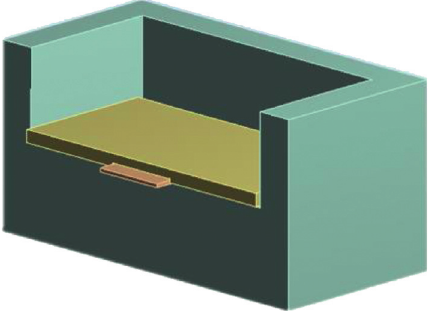
Figure 2: Model of transient dynamic analysis.